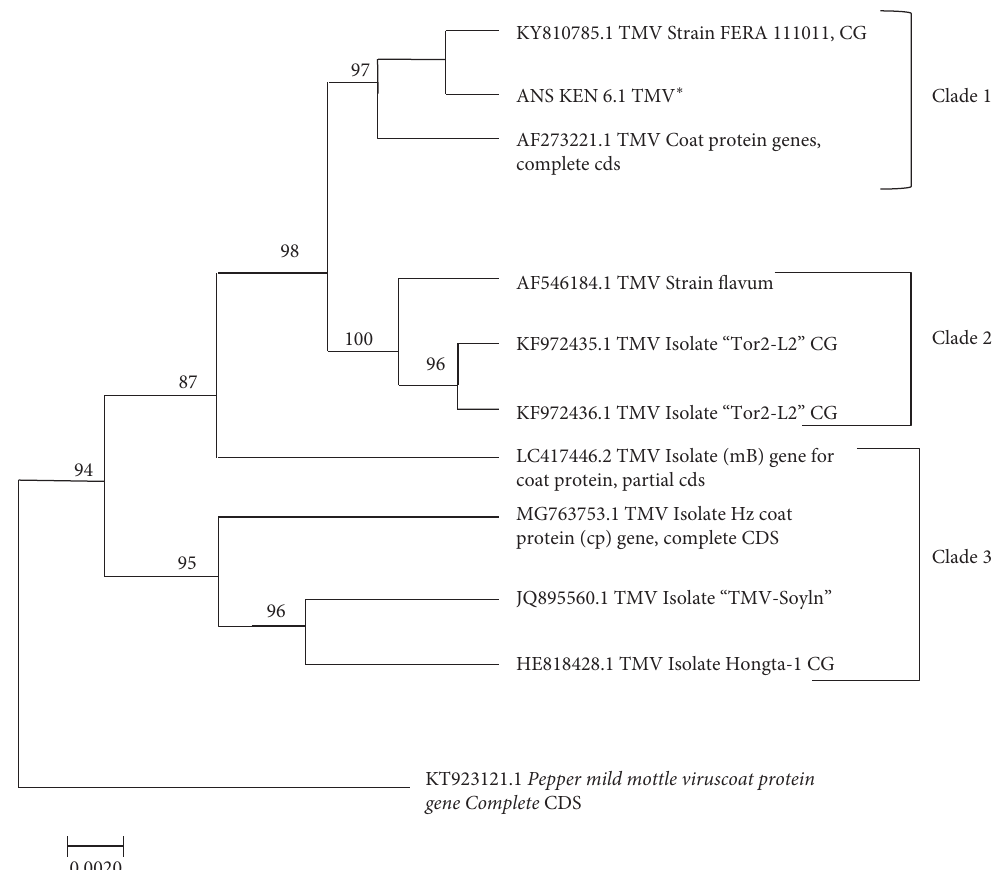
Figure 5: Phylogenetic analysis of Tobacco mosaic virus (TMV) isolates, with aligned nucleotide sequences, generated using the neighbor- joining method and MEGA6 software. The percentage of replicate trees in which the associated taxa clustered together in the bootstrap test (1000 replicates) is shown next to the branches. ∗ Kenyan ANS isolates. The tree was rooted using Pepper mild mottle virus (PMMoV) as an outgroup sequence for the phylogenetic